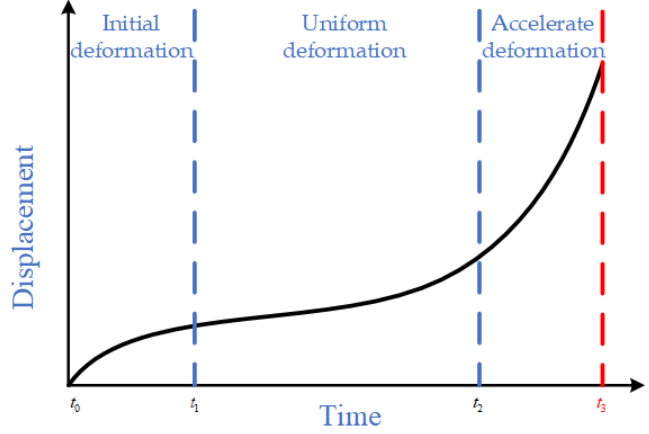
Figure 4. Saito curve model.